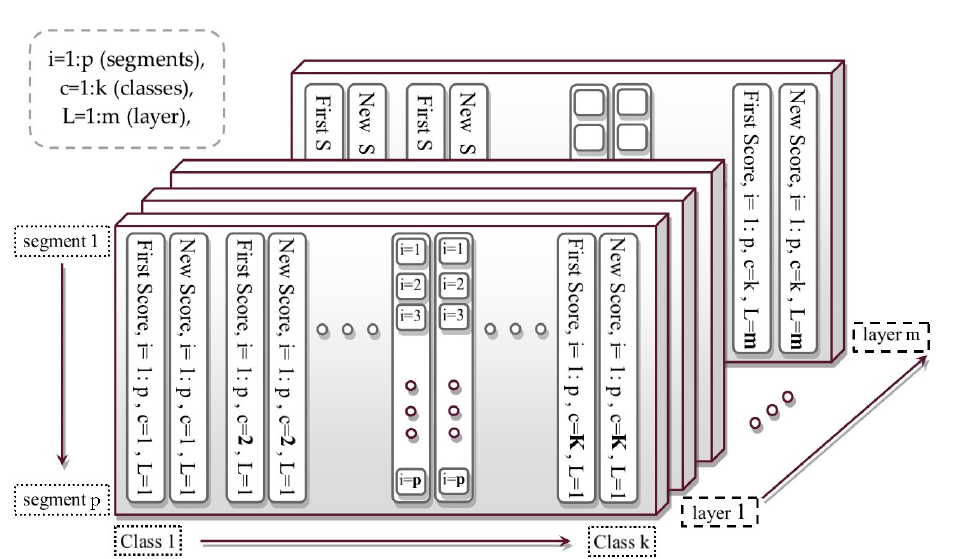
Figure 5. New scoring obtained from the weighted scores in three-dimensional score matrix.